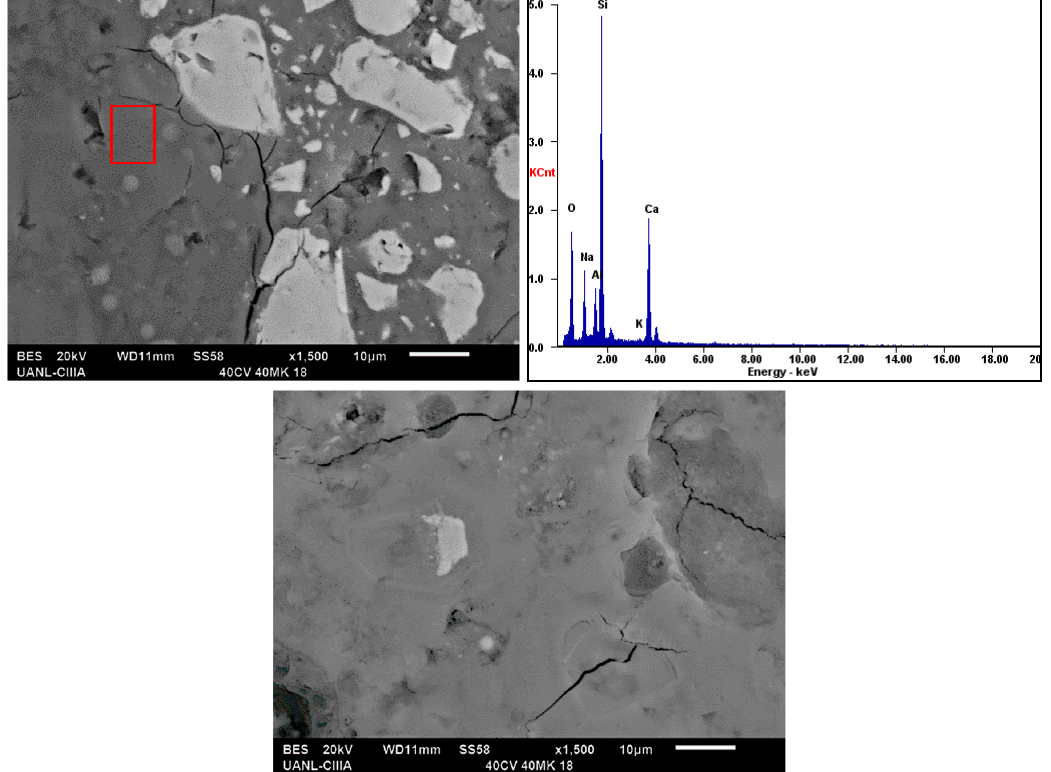
Figure 5. Micrographs of systems cured at 90 days with 18% Na 2 O as alkaline activator.